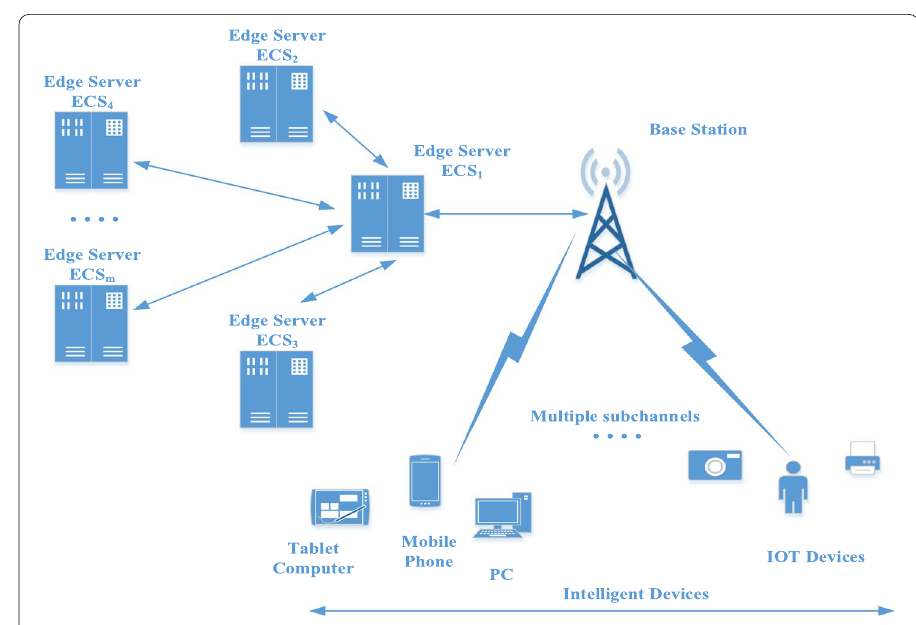
Fig. 2 Single-cell multi-user scenario in edge